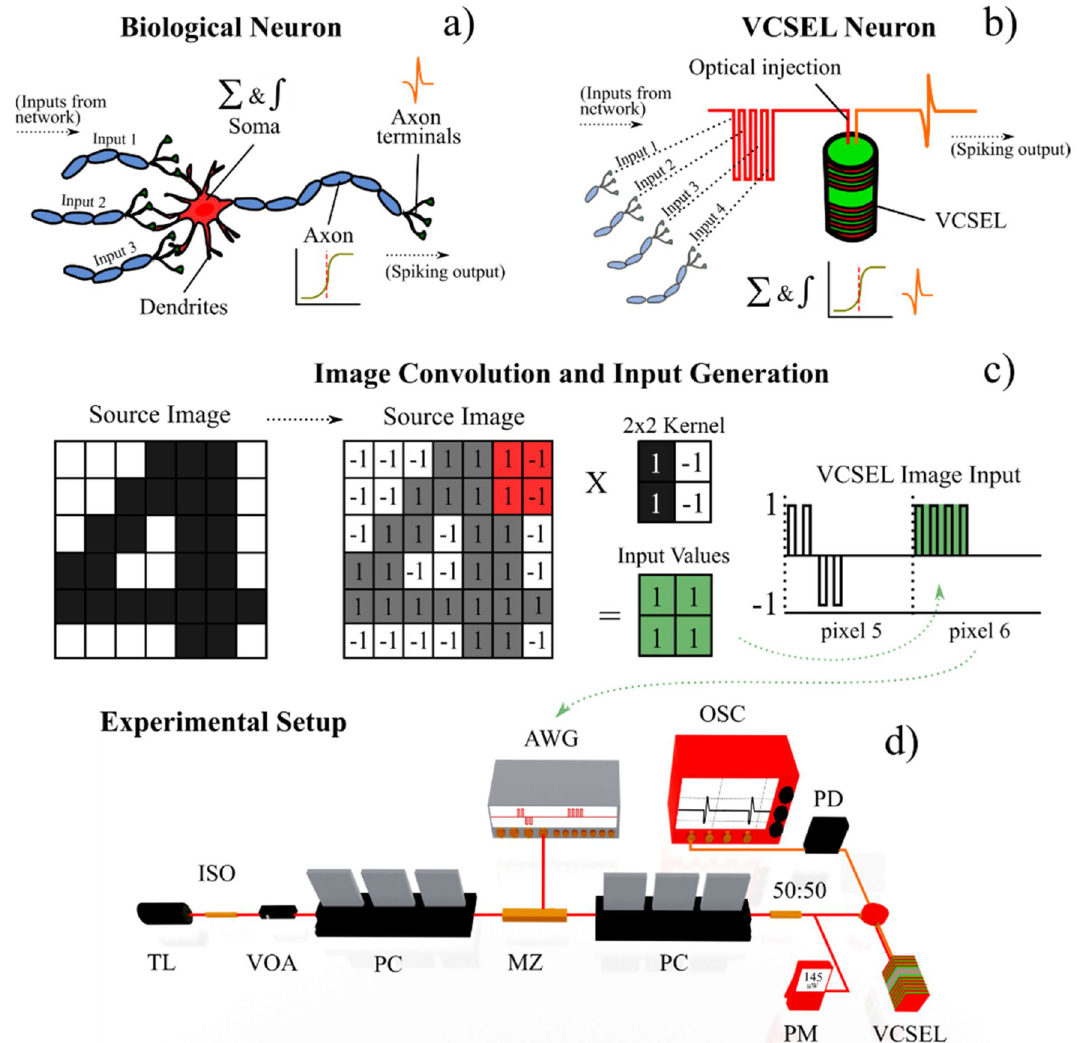
Figure 1. Image processing technique with a spiking VCSEL neuron. Diagrams of a biological (a) and an artificial optical VCSEL neuron (b) , illustrating the integration of multiple inputs and spike firing upon a threshold-exceeding input. Schematic of the image convolution and input generation process (c) . Source images are converted into binary matrices, 1’s (black) and −1’s (white) and operated on by a 2 × 2 kernel operator creating a Hadamard (elementwise) product. The product is used for the generation of a return-to-zero (RZ) image input, where each pixel is given a configurable duration. The kernel operator is scanned across the image, time-multiplexing the inputs generated for each pixel. Experimental setup (d) . The image input data is generated by an arbitrary waveform generator (AWG) and encoded, using a Mach Zehnder intensity modulator (MZ), into the light of a tuneable laser (TL). The injection light from the TL is directed into the VCSEL neuron using fibre-optic components; these include optical isolators (ISO), variable optical attenuators (VOA), polarisation controllers (PCs) and circulators (CIRC). The VCSEL neuron’s response is analysed with a fast real time oscilloscope (OSC) after detection with a photodiode